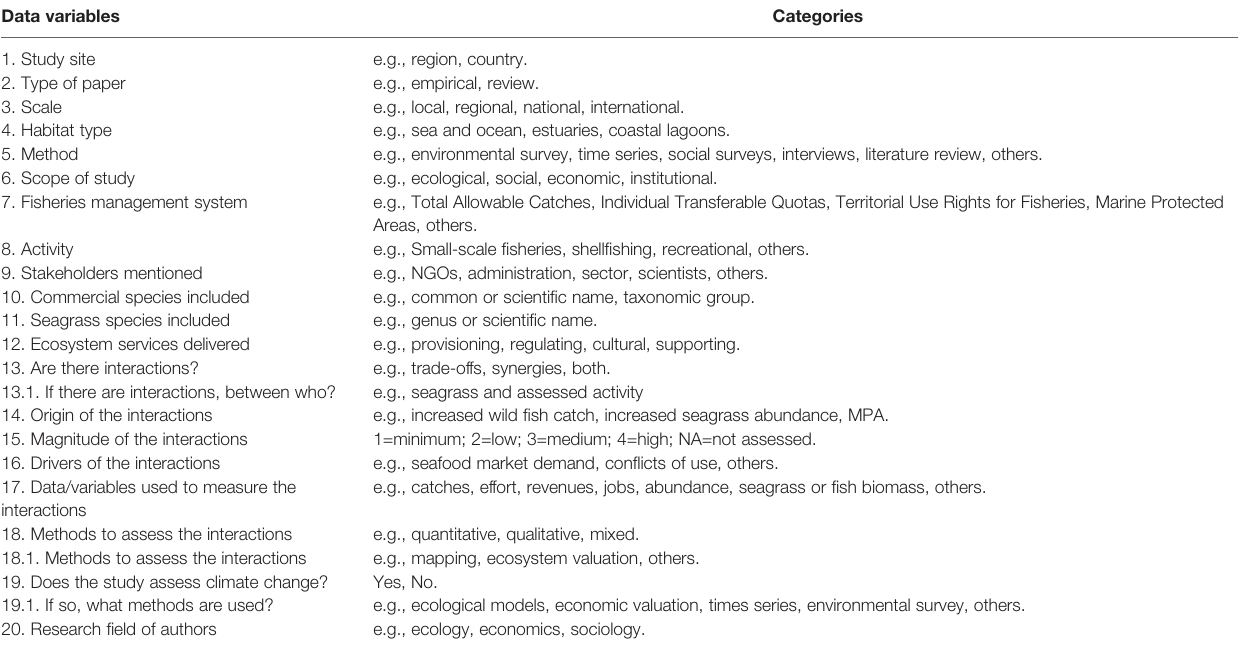
TABLE 1 | Data variables used to obtain information from the systematic literature